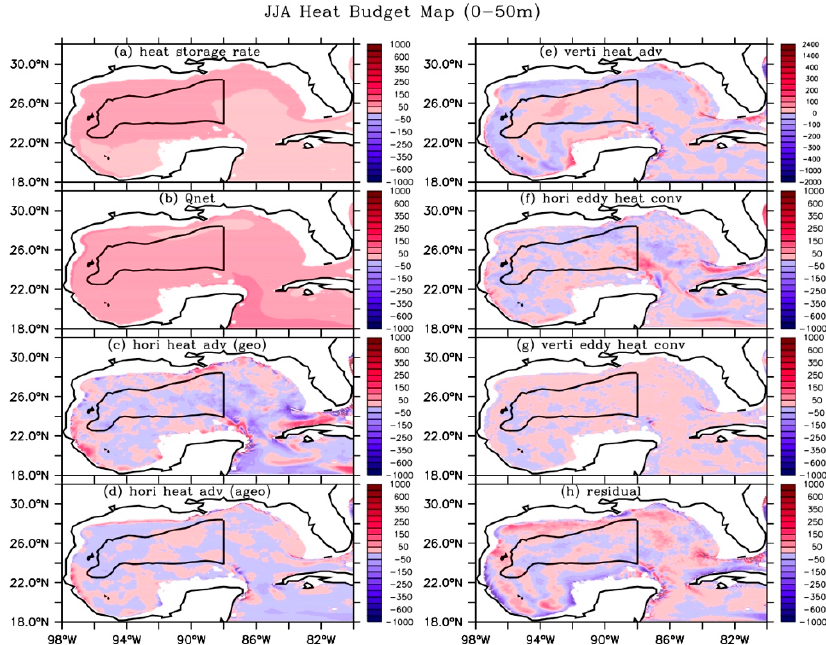
Figure 13. Mean heat budget terms ( a ) heat storage rate, ( b ) net surface heat flux Qnet, ( c ) horizontal heat advection by geostrophic current, ( d ) horizontal heat advection by ageostrophic current, ( e ) vertical heat advection, ( f ) horizontal eddy heat flux convergence, ( g ) vertical eddy heat flux convergence, and ( h ) the residual term in the top 50 m time-averaged over summer season (June–July–August; JJA). Only region deeper than 50 m is plotted. Unit: W m − 2 .